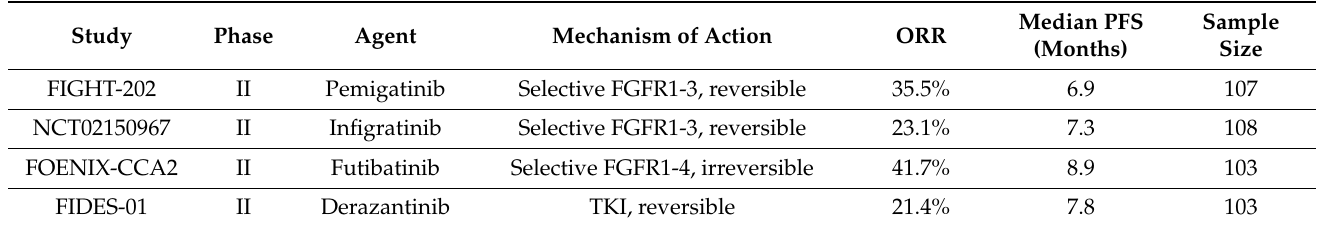
Table 1. A summary of some of the main results reported in clinical trials that investigated FGFR inhibitors in cholangiocarcinoma. Abbreviations: FGFR: fibroblast growth factor receptor; ORR: overall response rate; PFS: progression-free survival; TKI: tyrosine kinase